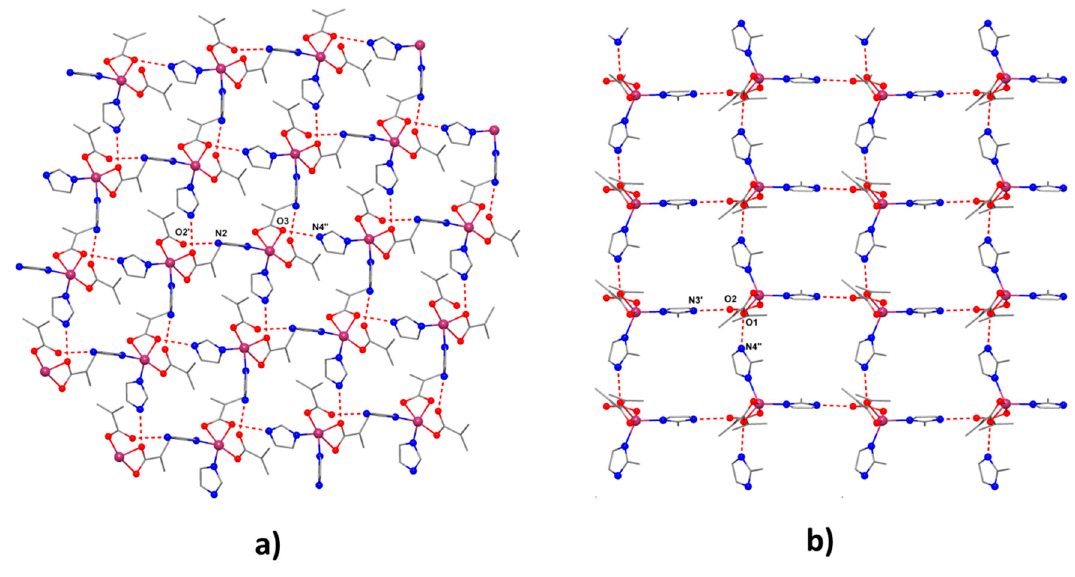
Figure 2. Supramolecular H-bonds networks for ( 1 ) ( a ) and ( 2 ) ( b ).